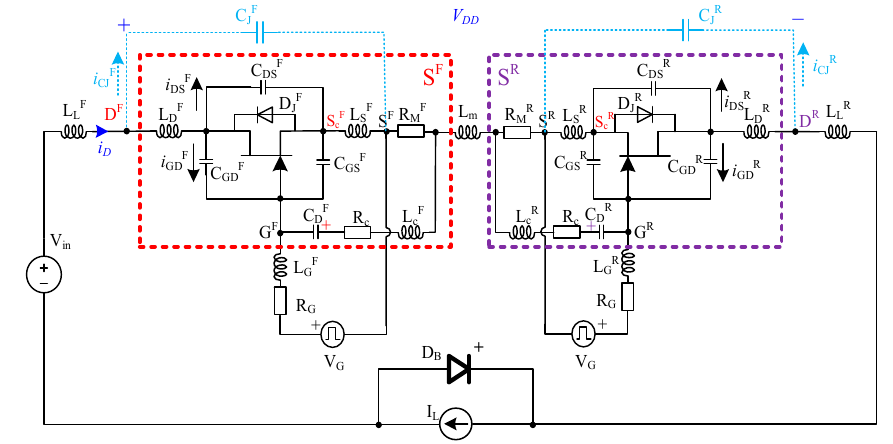
Figure 9. Transient circuit schematic diagram when paralleling C J .